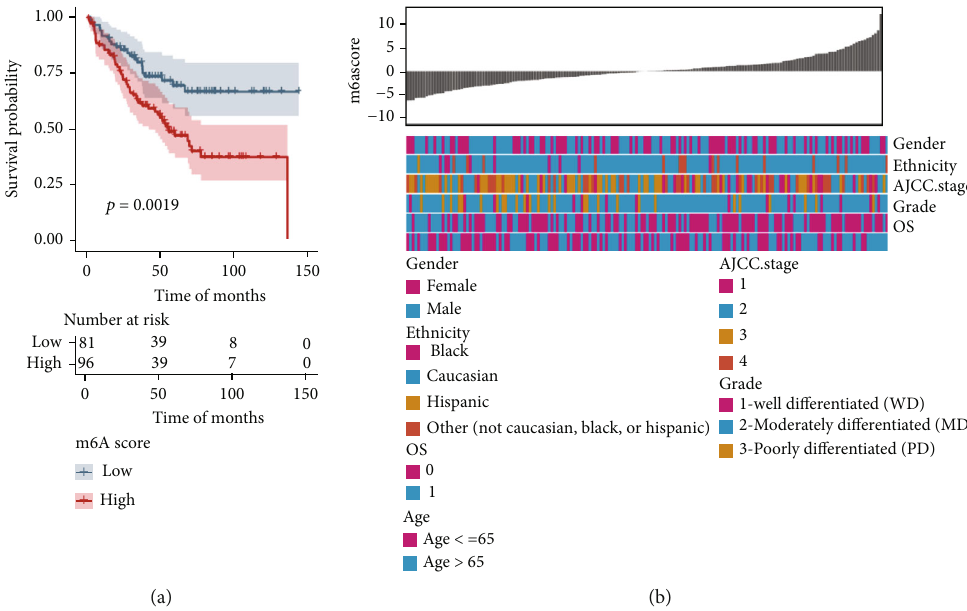
Figure 7: Evaluation of the predictive performance of m6Ascore in external datasets. (a) OS curves between high- and low-m6Ascore groups in the GSE17536 cohort. (b) A heat map depicting the correlation between m6Ascore and clinical characteristics in the GSE17536